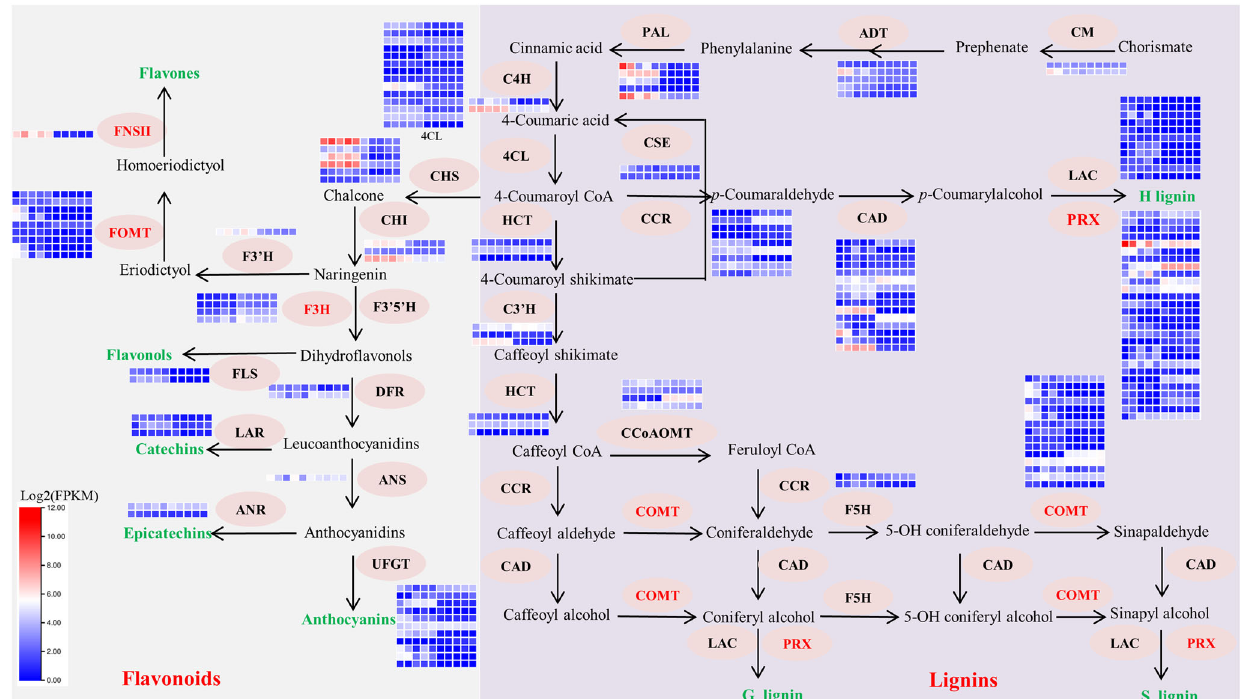
Fig. 5 The Phenylpropane Metabolic Pathway Illustrates in fl avonoids accumulation and lignin synthesis in Populus wilsonii . The lignin and fl avonoid biosynthesis pathways have a common precursor. Expanded genes are shown in red. Enzyme abbreviations: CM chorismate mutase, ADT